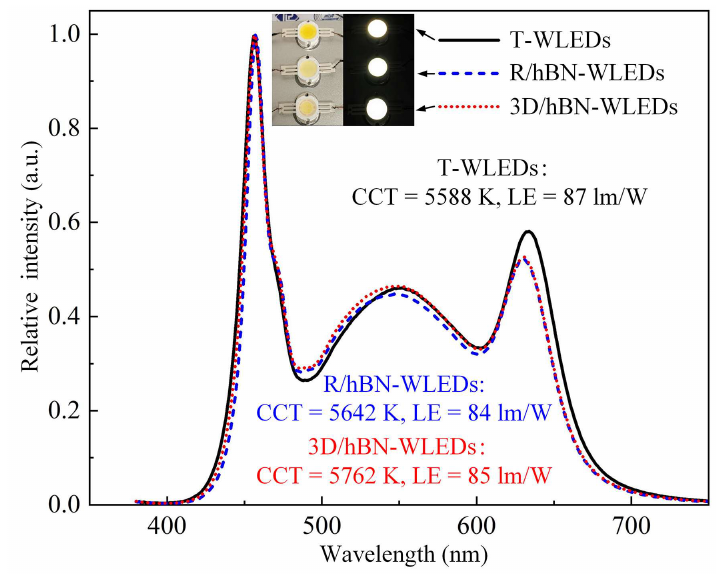
Figure 7. Optical spectra and key performance data of these WLEDs samples under 500 mA illumination. Insets show the photographs of these WLEDs working and not working.